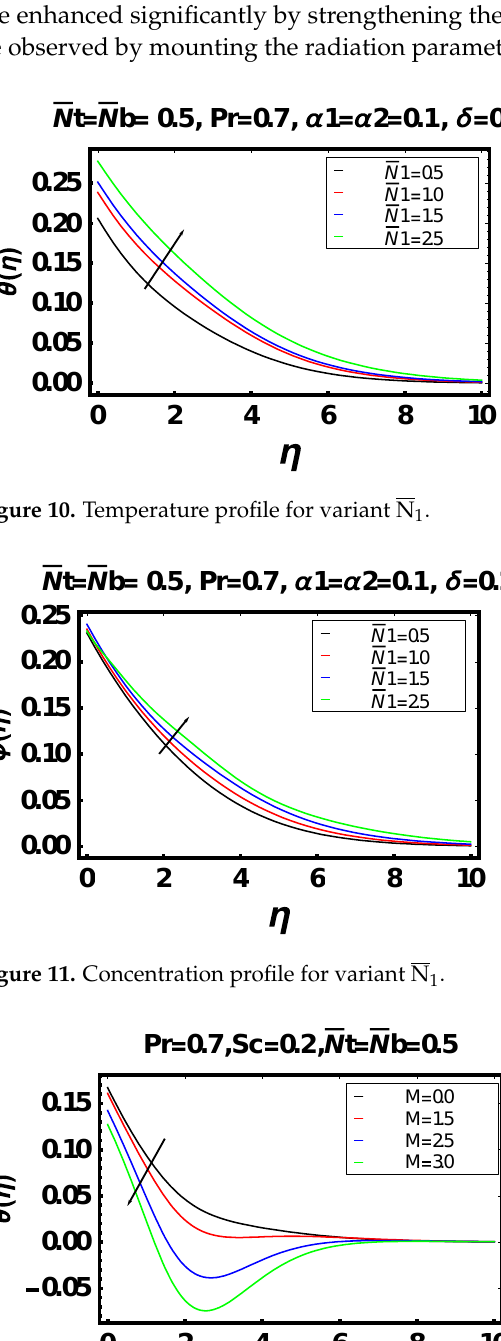
Figure 12. Temperature profile for variant M .